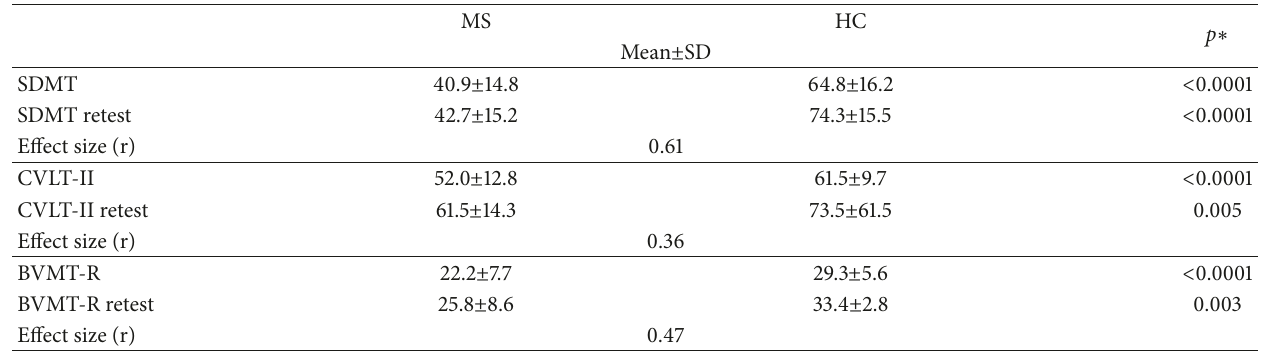
Table 2: Comparison of BICAMS score between MS and HC subjects.